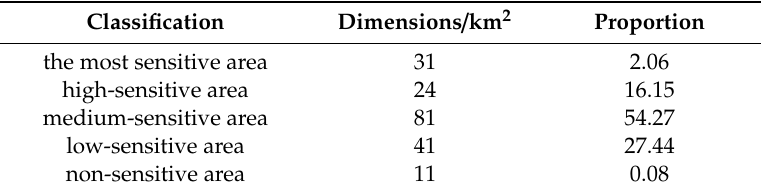
Table 1. Ecological sensitivity analysis.